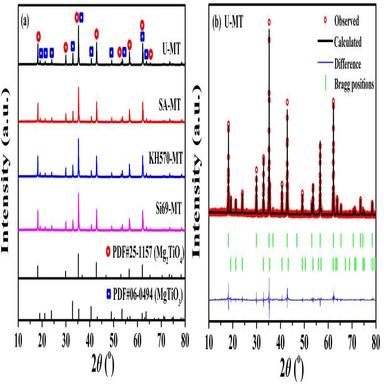
XRD relative spectra curves: (a) XRD measured curves of untreated and modified MT particles and (b) refined XRD pattern of U-MT particles.